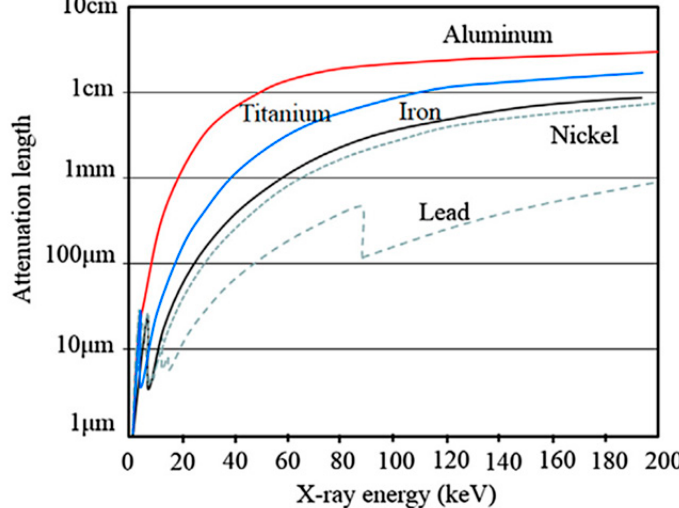
Figure 2. The X-ray attenuation length (which is the distance through which 37% of the X-ray will penetrate) through various metals as a function of X-ray energy intensity will penetrate) through various metals as a function of X-ray energy [7].